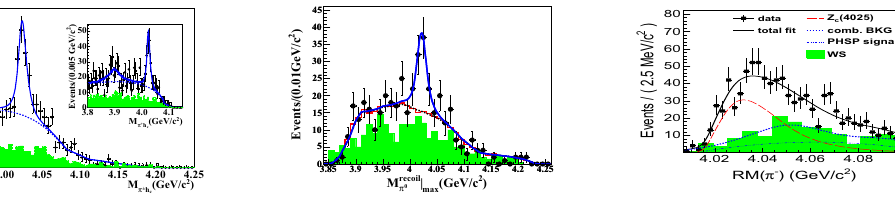
Figure 8. Sum of the simultane- Figure 9. Sum of the simultane- distributions at ous fit to the M π ± h ous fit to the M max ( π 0 h c ) distribu- c 4.23, 4.26, and 4.36 GeV. tions at 4.23, 4.26, and 4.36 GeV.